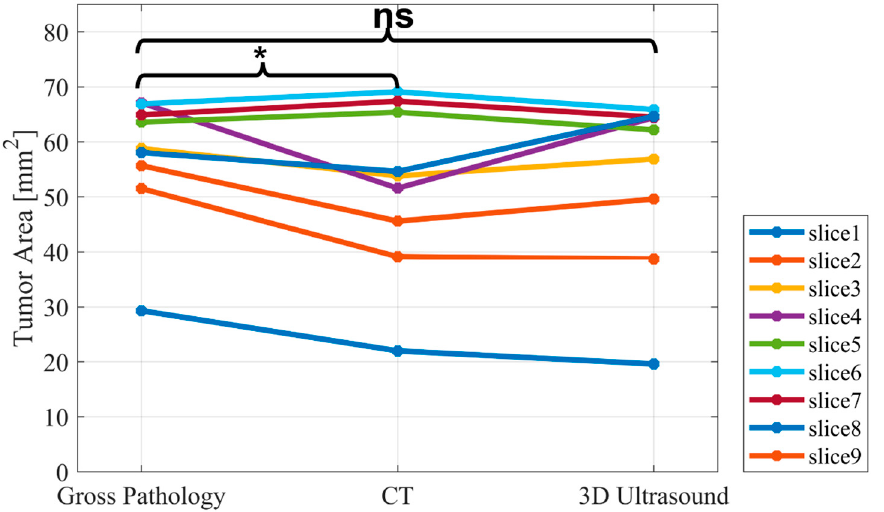
Figure 5. Paired t -test for statistical evaluation of the CT and 3D ultrasound compared to gross pathology. ns stands for non-significant, and * stands for significant.